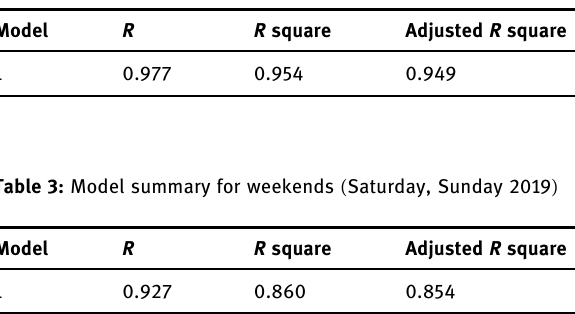
Table 2: Model summary for weekdays ( Friday, Monday, Tuesday,